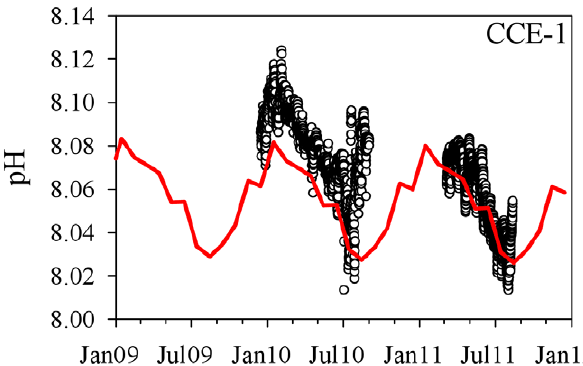
Figure 4. Comparison between sensor data (symbols) and the pH climatology (line) near